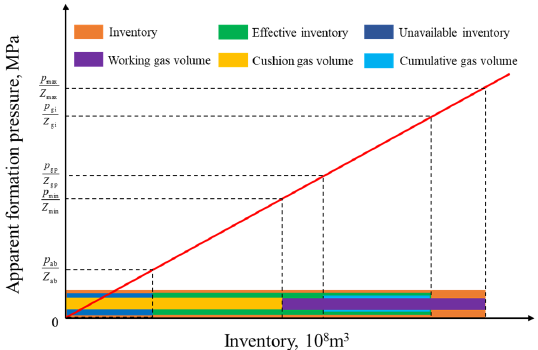
Figure 6. The inventory evaluation parameters of UGS in the material balance method (modified from Ma et al. [50]).